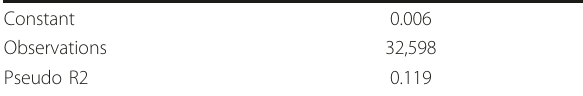
Table 6 Results of Logistic Regression Analyses Alterna- tive Health Care Consultations: All Consultations Age